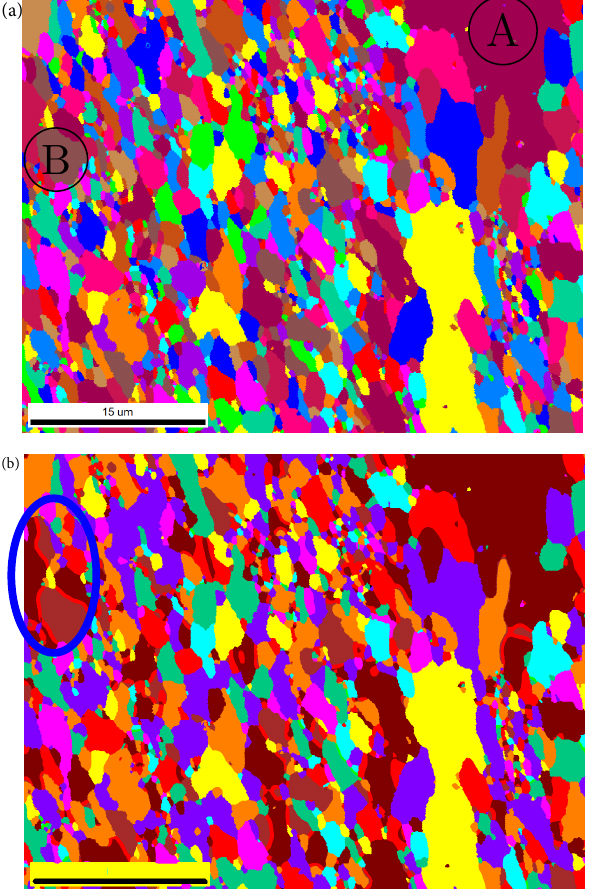
Fig. 6: Denoising in postprocessing: (a) binary image Fig. 7: EBSD image from another Figure 7. EBSD image from another source for a nanostructured ferritic alloy: ( a ) original EBSD shown in monotonic color (magenta rectangle in Fig. 5 (d)) image; ( b ) segmented final source for a nanostructured ferritic al- with disturbances shown in white in black grains and vi- loy: (a) original EBSD image; (b) seg- ce versa; (a) corresponding image of (a) after denoising mented final result. (magenta rectangle in Fig. 5 (e)).